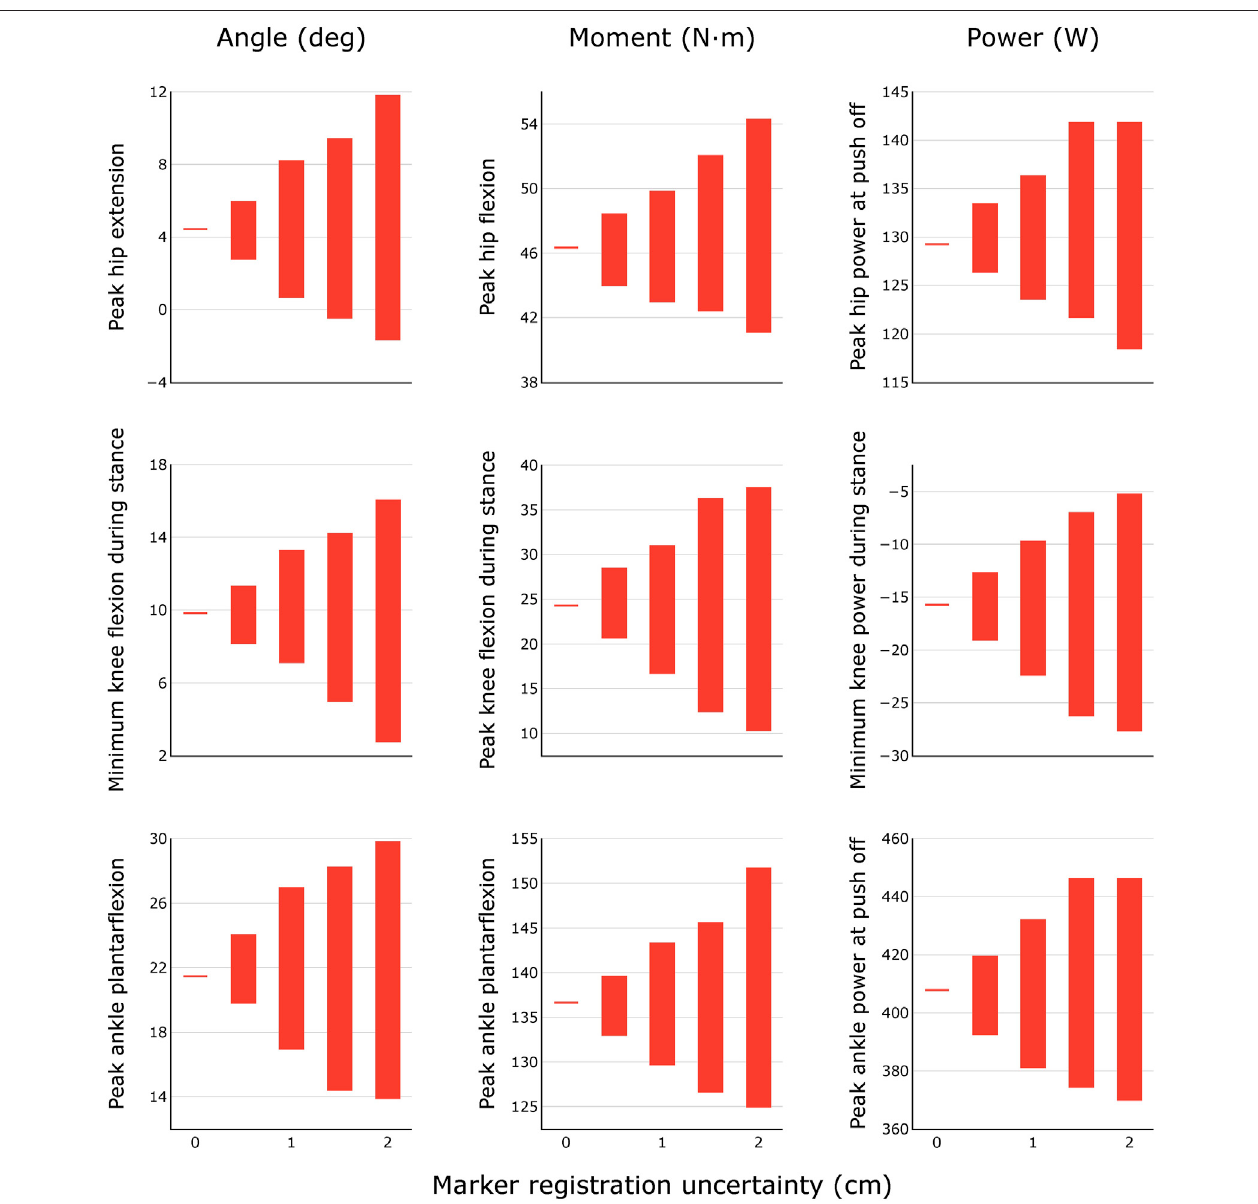
FIGURE4| Variabilityinpeakjointangles,moments,andpowersduringhealthywalkingfordifferentlevelsofmarkerregistrationuncertainty.Resultswereobtained by generating N = 100 equally probable models at each level of uncertainty.